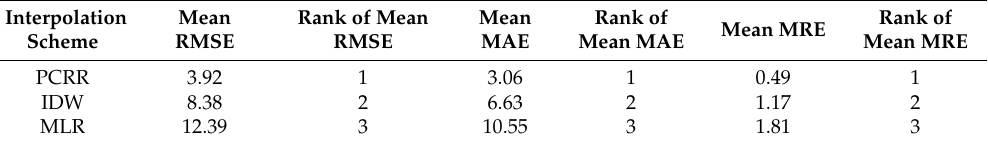
Table 5. Cross validation performance and ranking of different interpolation schemes for simulating daily precipitation.